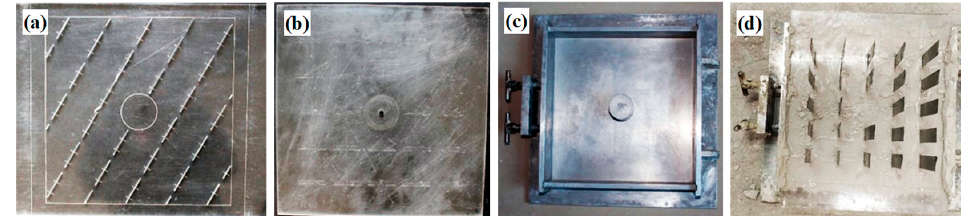
Figure 2. The mold and fabrication process of a specimen: ( a ) the cover plate, ( b ) the base plate, ( c ) the frame installed with the base plate and the cylinder, and ( d ) a specimen before solidification.